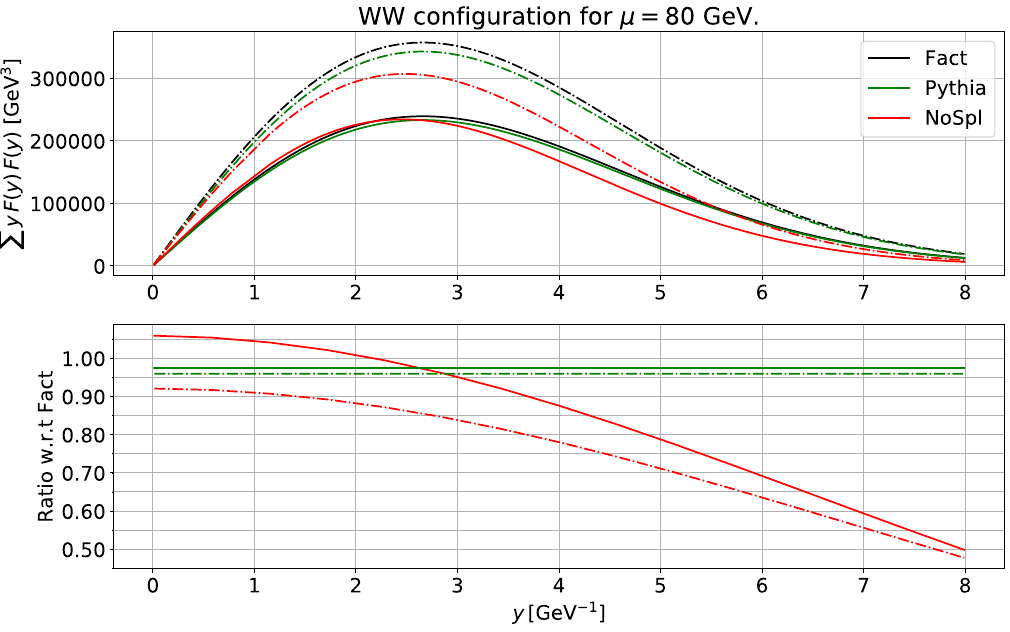
Figure 8 . Integrand of the luminosity (divided by 2 (cid:25) ) given by eq. (5.3) as a function of y for p s = 14 TeV and for the WW con(cid:12)guration. The solid lines correspond to the value Y = 0, whereas the dashed-dotted lines give the results for Y = 3. The y -dependence of the dPDFs for the setups Fact and Pythia is simply the Gaussian factor given by eq. (5.6). The setup Fact is the reference in the ratio